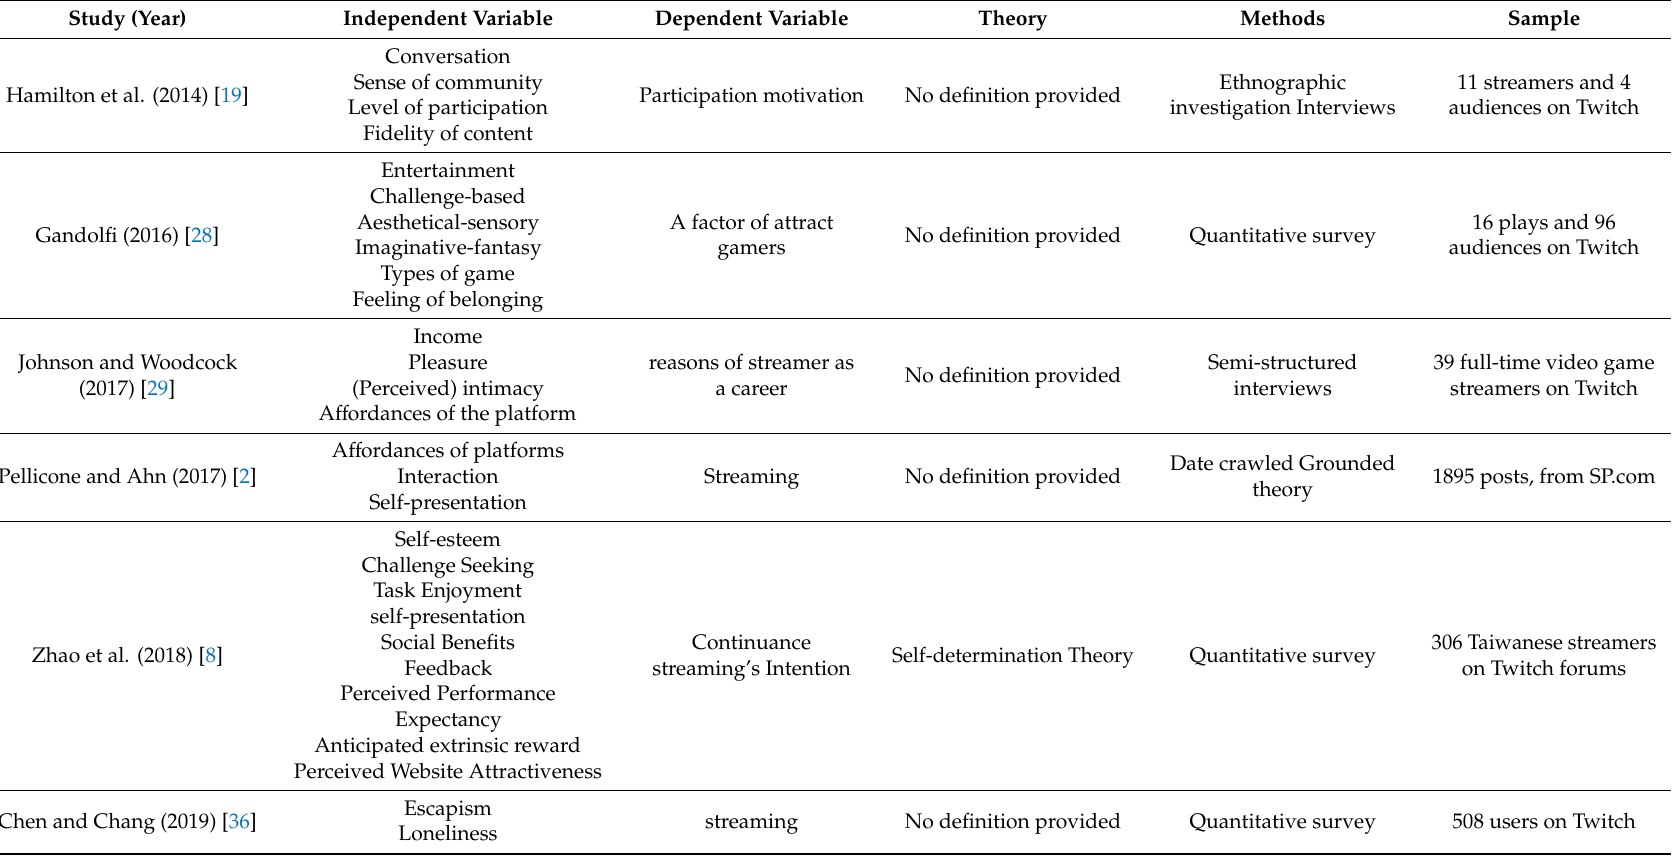
Table A1. Summary of studies included in the streamer